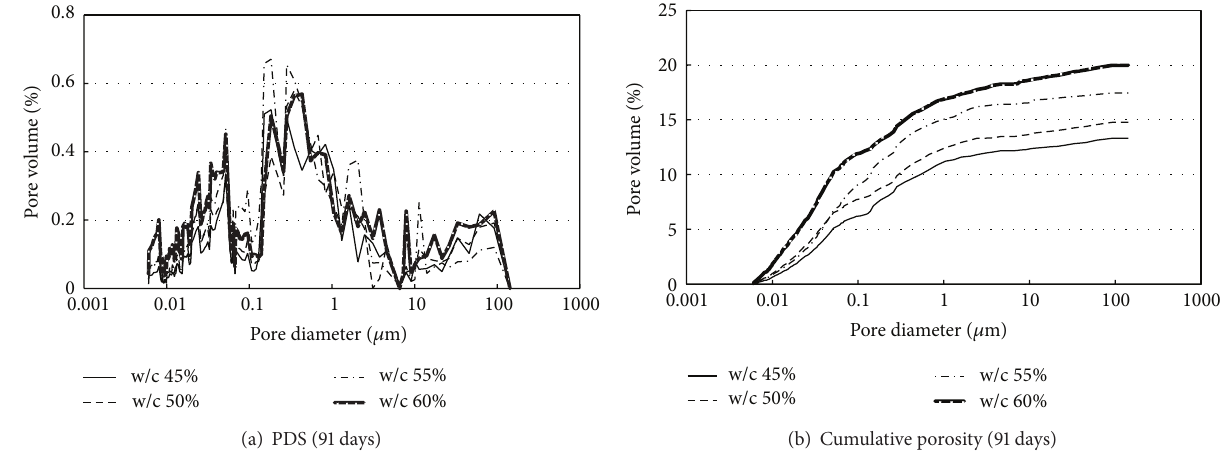
Figure 2: PSD and total porosity.